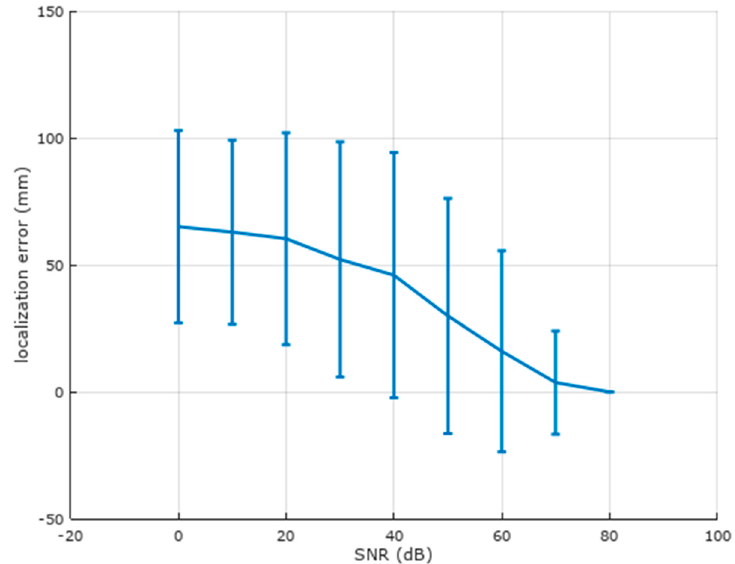
Figure 4. Localization error vs. signal-to-noise (SNR) ratio for the spherical model. Mean and standard deviation are shown for 250 randomized trials at each SNR. Localization is poor below 70 dB (the radius of the cortical sphere is 63 mm).